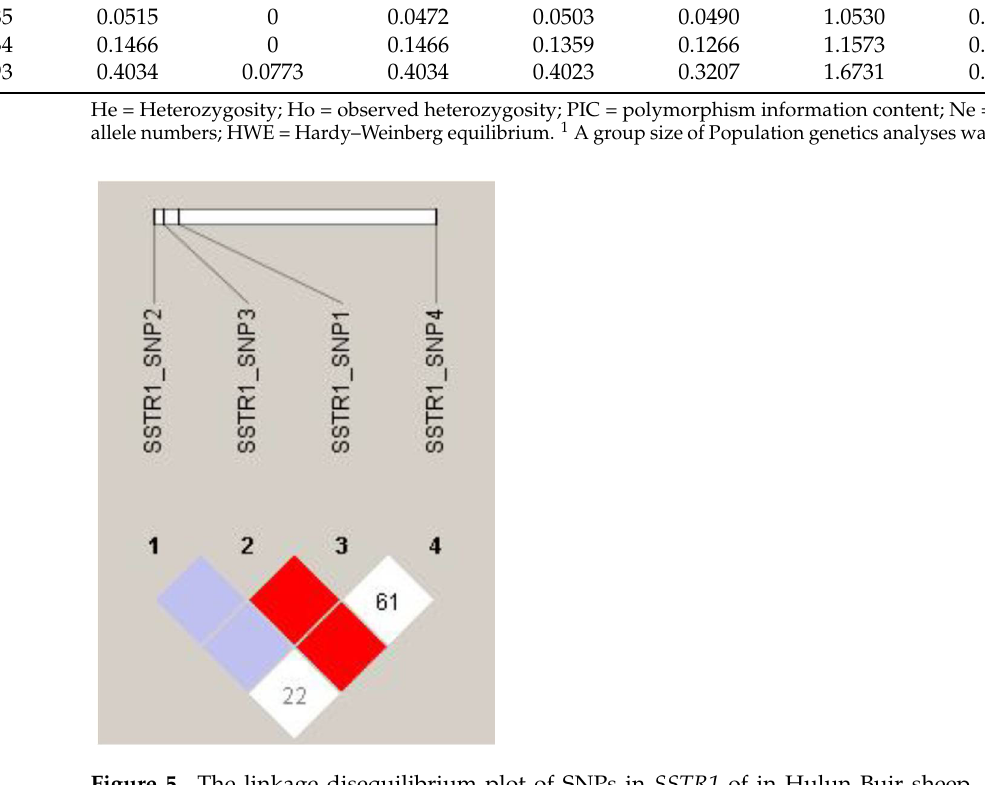
Figure 5. The linkage disequilibrium plot of SNPs in SSTR1 of in Hulun Buir sheep. Linkage disequilibrium (LD) estimated among SSTR1 variations in Hulun Buir sheep. The R2 values indicated the group of SNP1, SNP3, and SNP4.